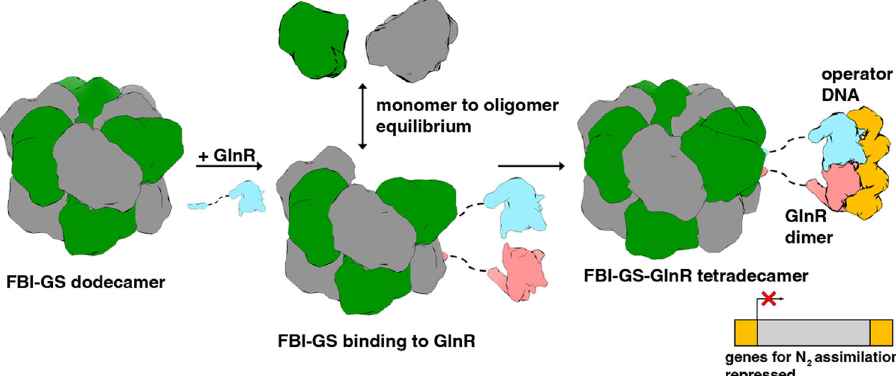
Fig. 9 Schematic showing a structure-based mechanism of FBI-GS activation of GlnR proteins in Gram-positive bacteria. GS and GlnR are shown as schematic surface renderings with GS subunits colored gray and green and GlnR subunits colored pink and light blue. In the model GlnR binding stabilizes or facilitates subunit exchange and, in some bacteria, the transition of GS from a dodecamer to a tetradecamer. GlnR is monomeric but the interaction of two GlnR subunits in the same side pore brings them into proximity and allows them to dimerize on cognate DNA (shown as a yellow cartoon) and thus regulate genes important in nitrogen